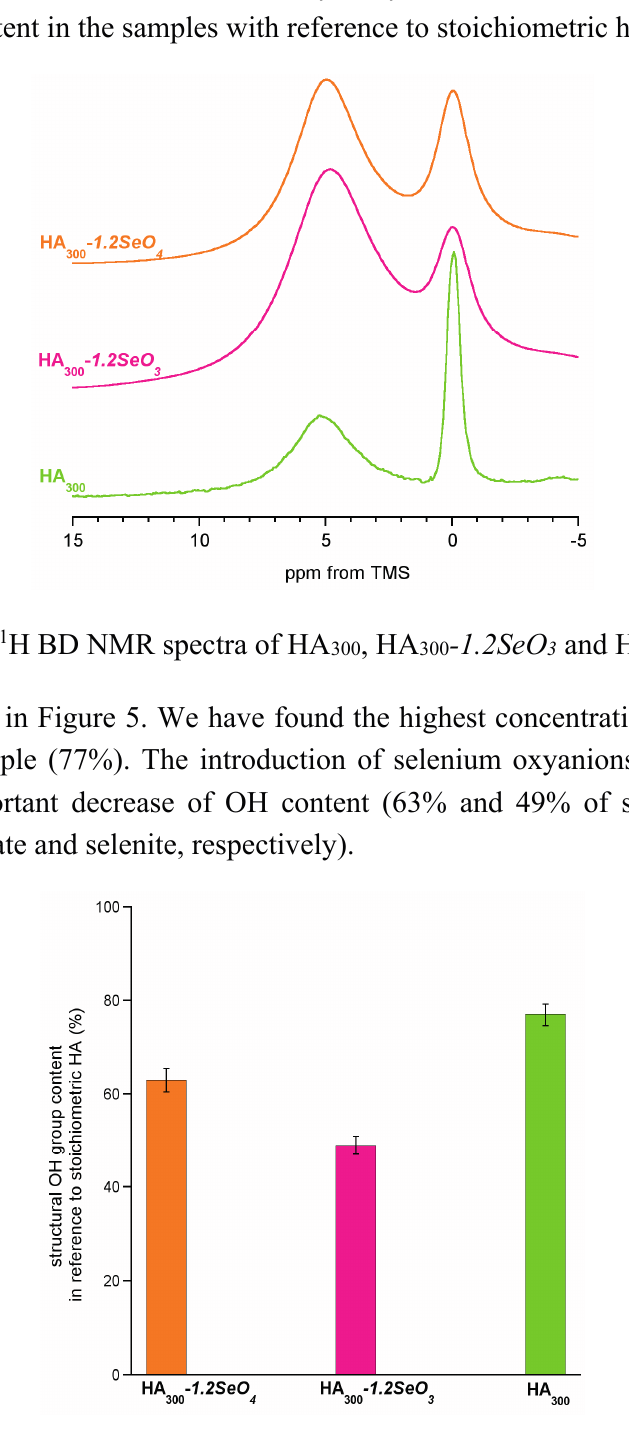
Figure 5. Structural hydroxyl groups content in reference to stoichiometric hydroxyapatite